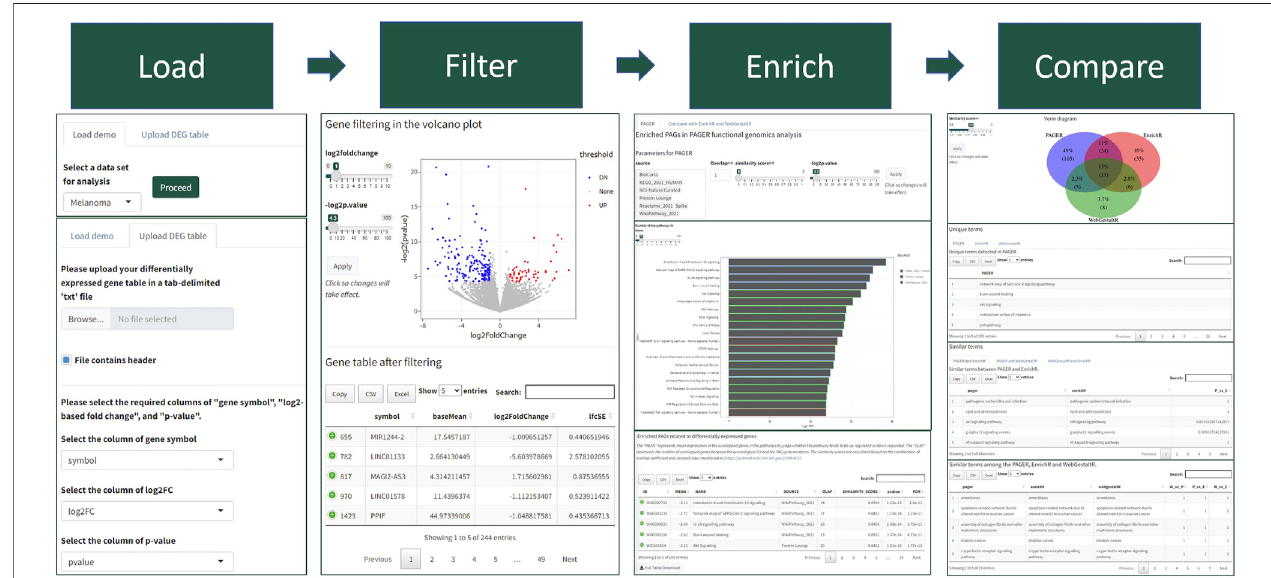
FIGURE 1 | The PAGER Web APP data analysis work fl ow. The work fl ow consists of four steps with visualization panels to help biologists quickly understand the results.